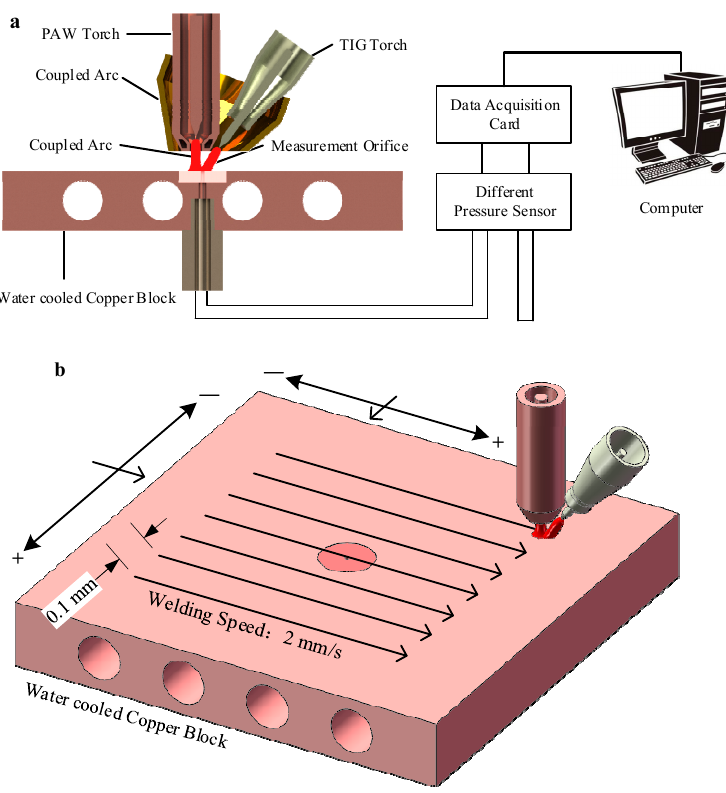
Figure 7. Measurement system of the arc pressure. ( a ) The schematic diagram of the arc pressure data acquisition system. ( b ) The schematic diagram of the acquisition methods for coupled arc pressure.